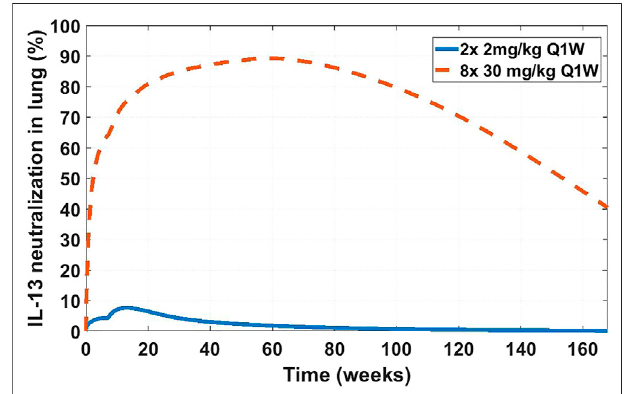
FIGURE 9 | Projected IL-13 neutralization in lung at two dosing schedules for IMA-026. Two doses of 2 mg/kg a week apart (solid blue line) wastheclinicallytesteddoseinasthmapatients(NCT00725582).Eightdoses of 30 mg/kg a week apart (dashed orange line) is a hypothetical clinical dose at which the projected IMA-026 coverage reaches close to 90% IL-13 neutralization in the lung. Modeling suggests that the mechanism of IL-13 neutralization was likely untested in the clinic due to low tested dose, which is projected to result in low coverage.